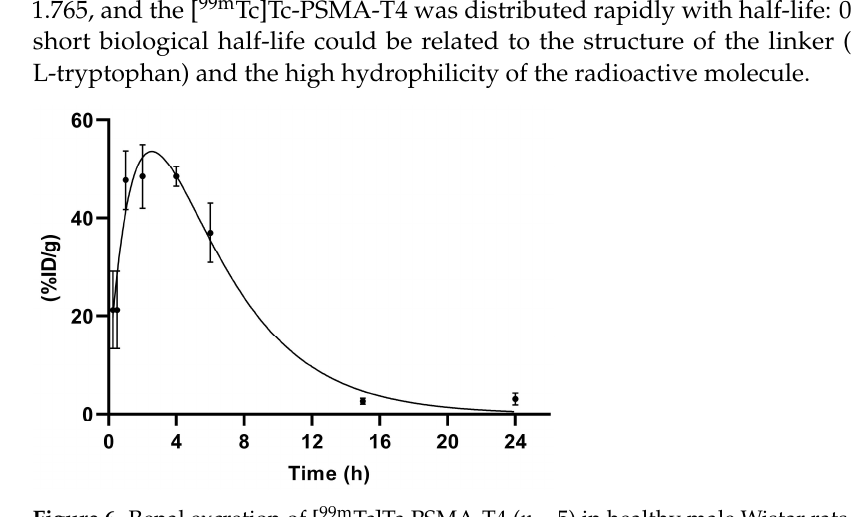
Figure 5. Blood elimination of [ 99m Tc]Tc-PSMA-T4 ( n = 5) in healthy male Wistar rats. Data presented